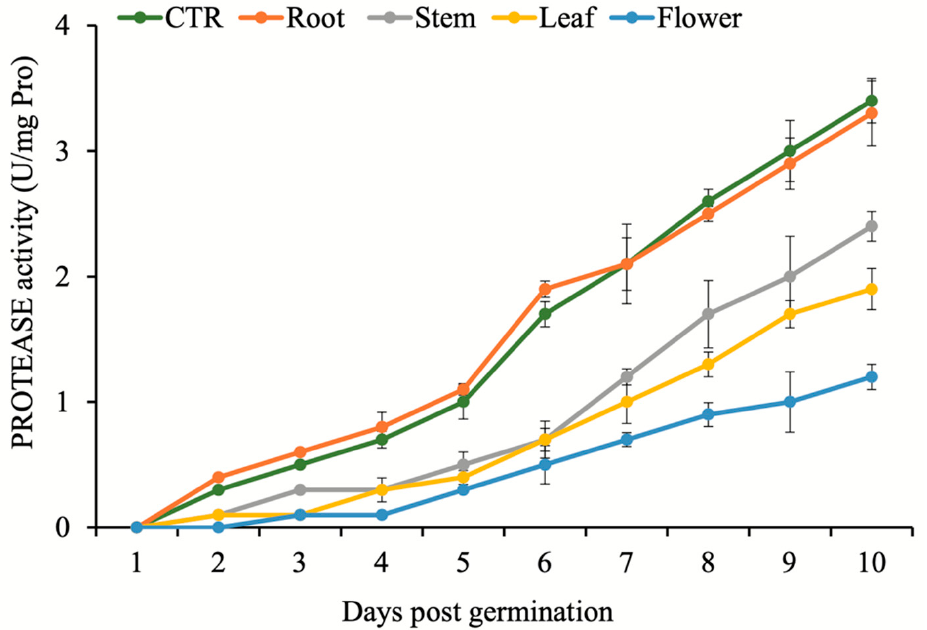
Figure 2. Effect of N. meyeri extracts on protease activity in germinating C. campestris (dodder) seeds. Dodder seeds were treated either by distilled water (CTR) or extracts from different N. meyeri plant parts. Error bars represent standard errors calculated from three biological replicates .